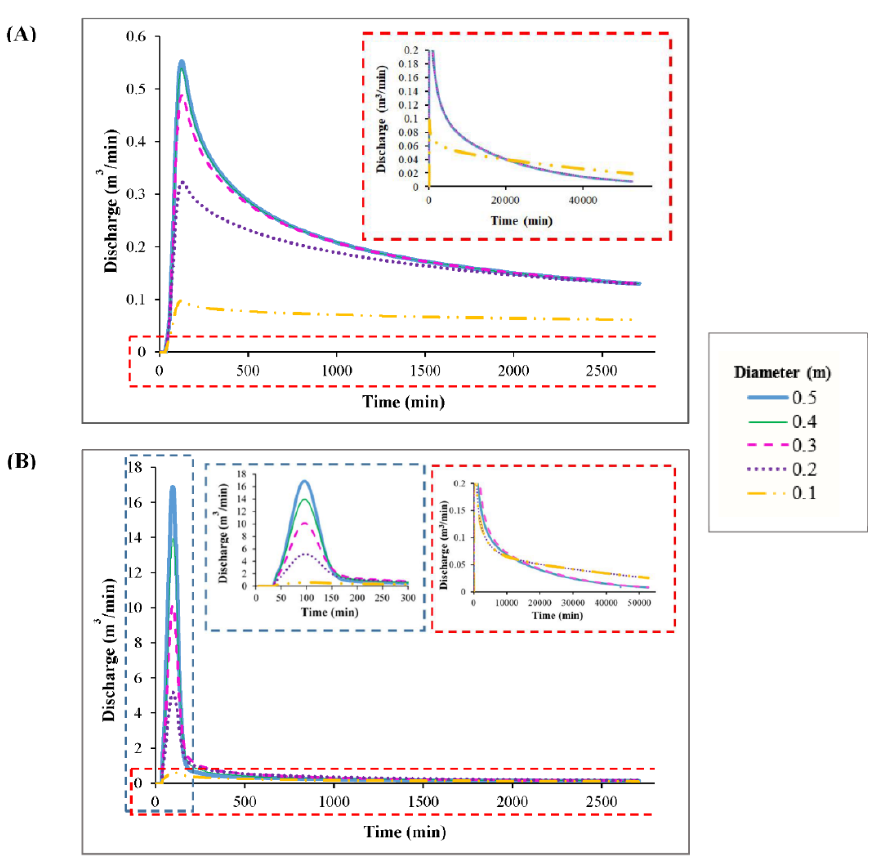
Figure 6. Spring hydrograph variability in relation to conduit diameter changes in scenarios A2 (Figure A ) and B2 (Figure B ).